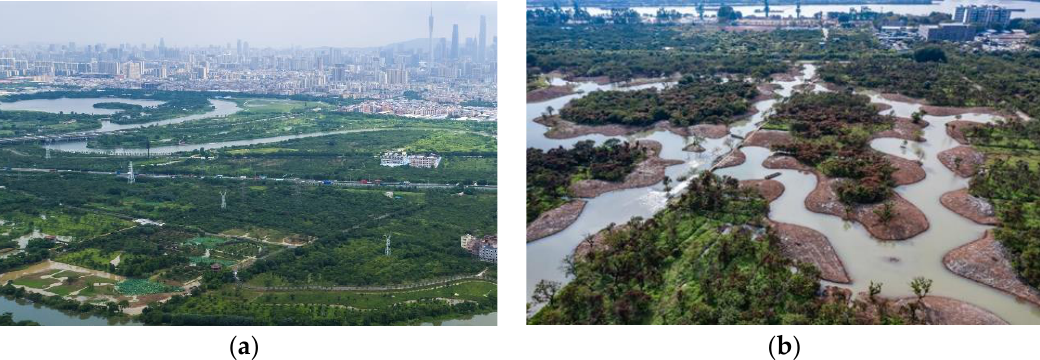
Figure 4. Loss of traditional agricultural landscape: ( a ) Haizhu Lake with an area of 53 hm 2 con- structed in 2011 (Credit: Huiqiang Xie); ( b ) Landscape after implementing an ecological restoration project (Credit: Huiqiang Xie).